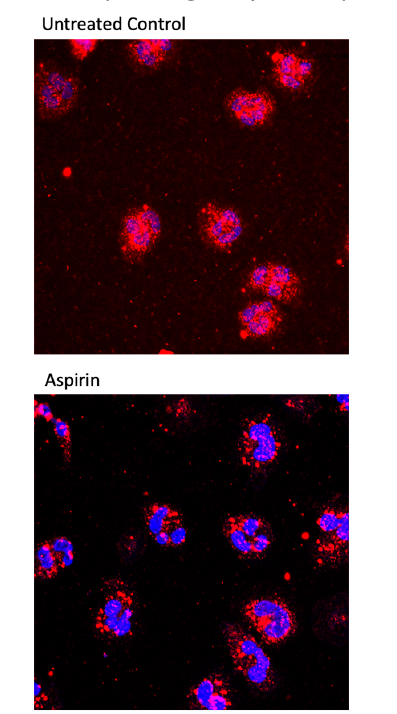
Figure 5. Confocal images for preeclamptic pregnancy neutrophils. Red fluorescence, the p65 subunit of NF- κ B; DAPI blue location of nucleus. x63 lens.